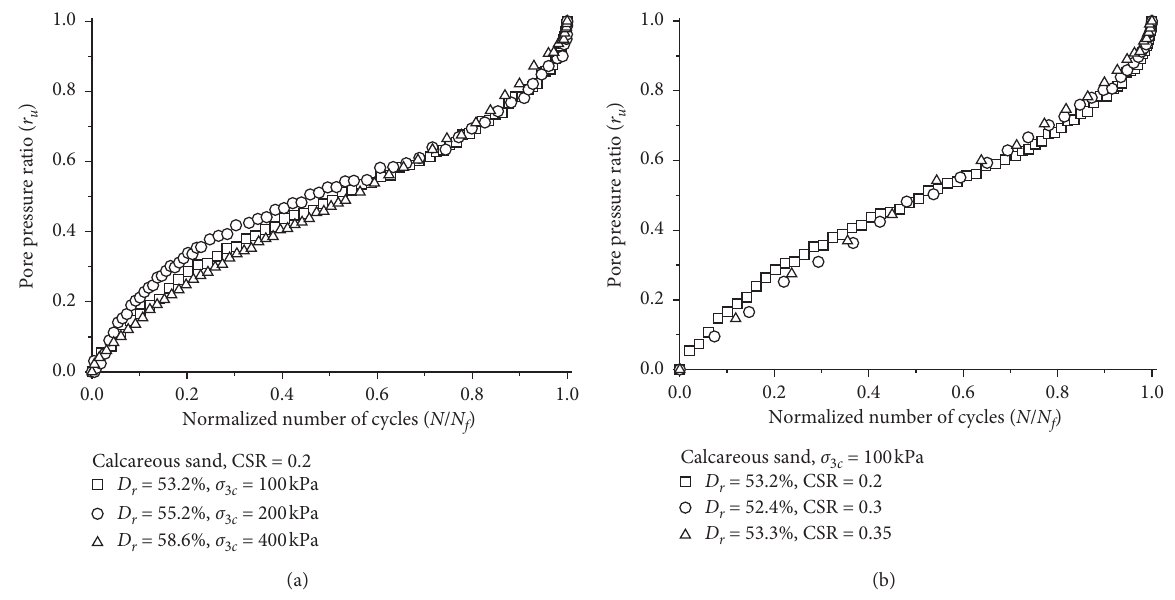
Figure 12: Pore pressure growth curves of typical samples. (a) CSR � 0.2 of calcareous sands. (b) σ